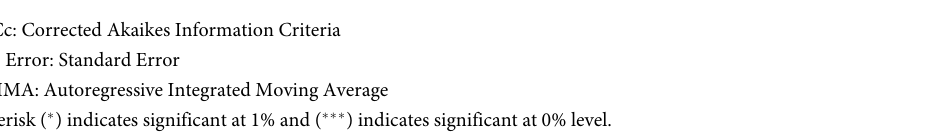
Table 1. Estimated parameters of the ARIMA (0,1,1) with drift model. Parameters Estimate Std. Error z value Pr( > |z|) ma1 -0.32448